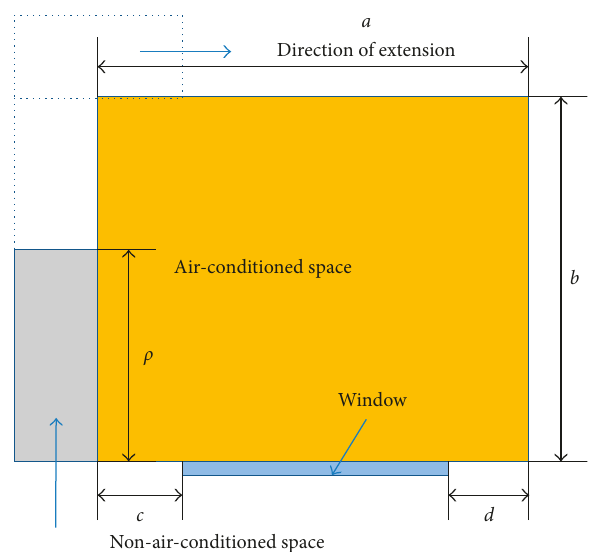
Figure 6: Methodology of creating